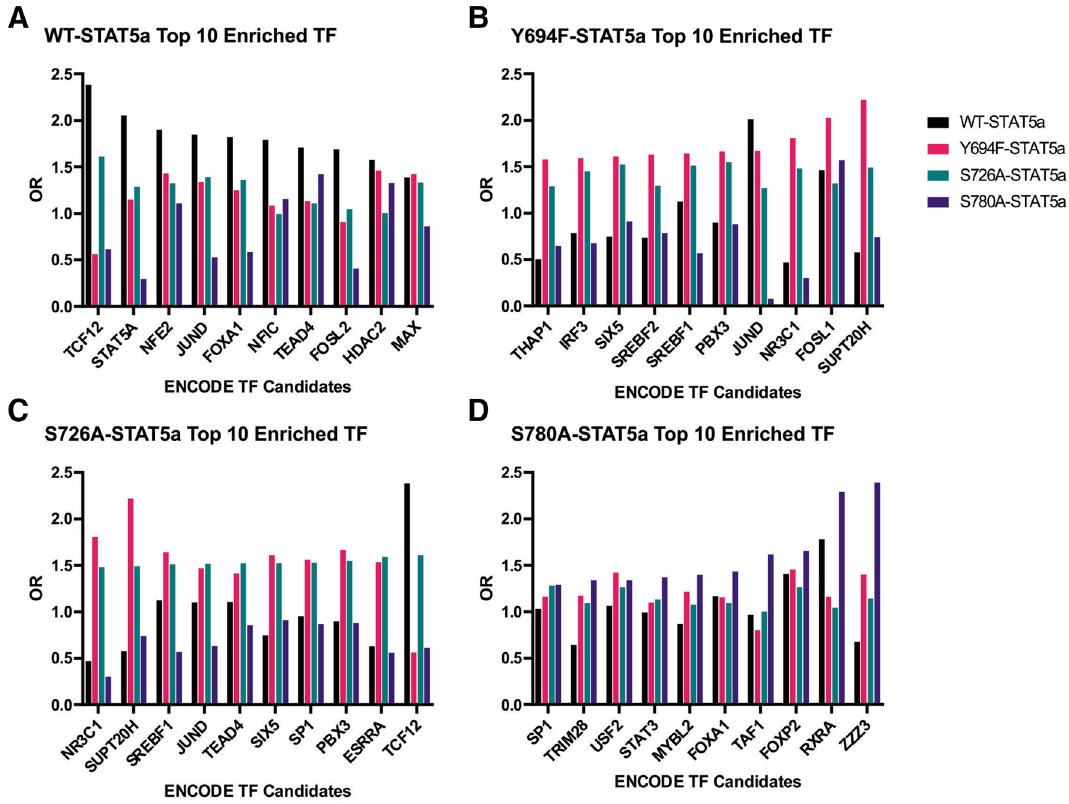
Figure 7. Transcription factor gene set analysis identifies complex transcriptional networks contributing to STAT5a mutant-driven phenotypes. TF analysis of the DEGs from MCF7 cells treated with PRL for ( A ) WT-STAT5a, ( B ) Y694F-STAT5a, ( C ) S726A-STAT5a, and ( D ) S780A-STAT5a. The ENCODE project ChIP- seq data set library was used to find the top-ranking transcription factors by odds ratio (OR), p < 0.05. Graphs generated in GraphPad Prism 9.0.0 for Windows (GraphPad Software, San Diego, California USA, www. graph pad.